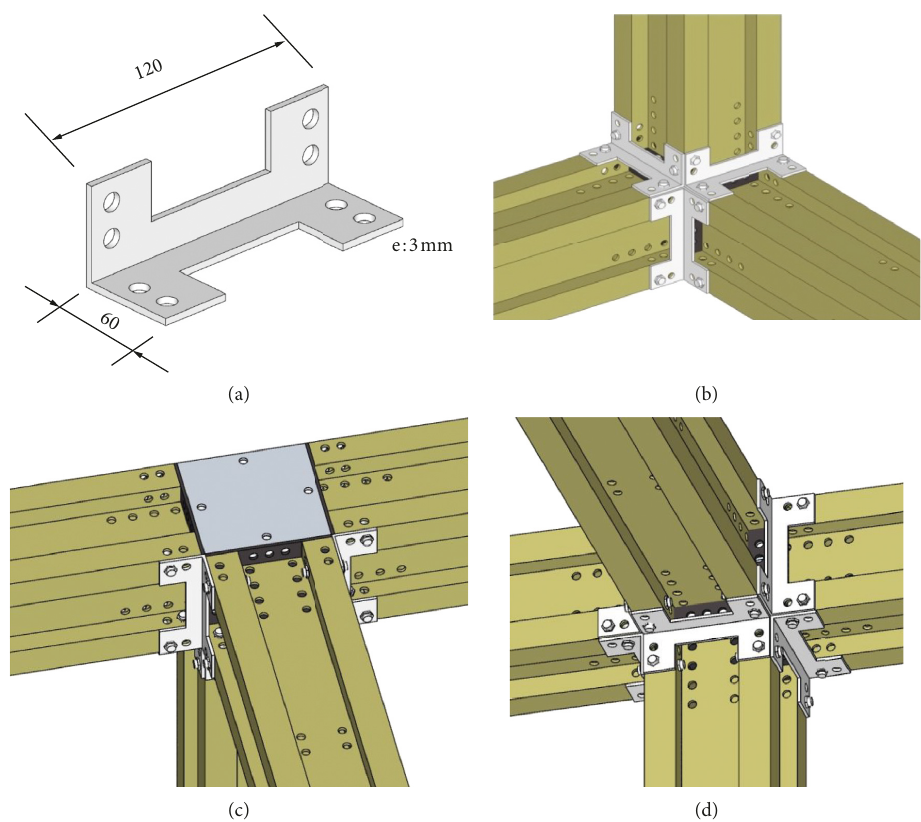
Figure 11: Joints performed by means of the unique framing square. (a) Unique framing square, (b) assembly by the framing squares, (c) top view of a 3D joint, and (d) bottom view of a 3D